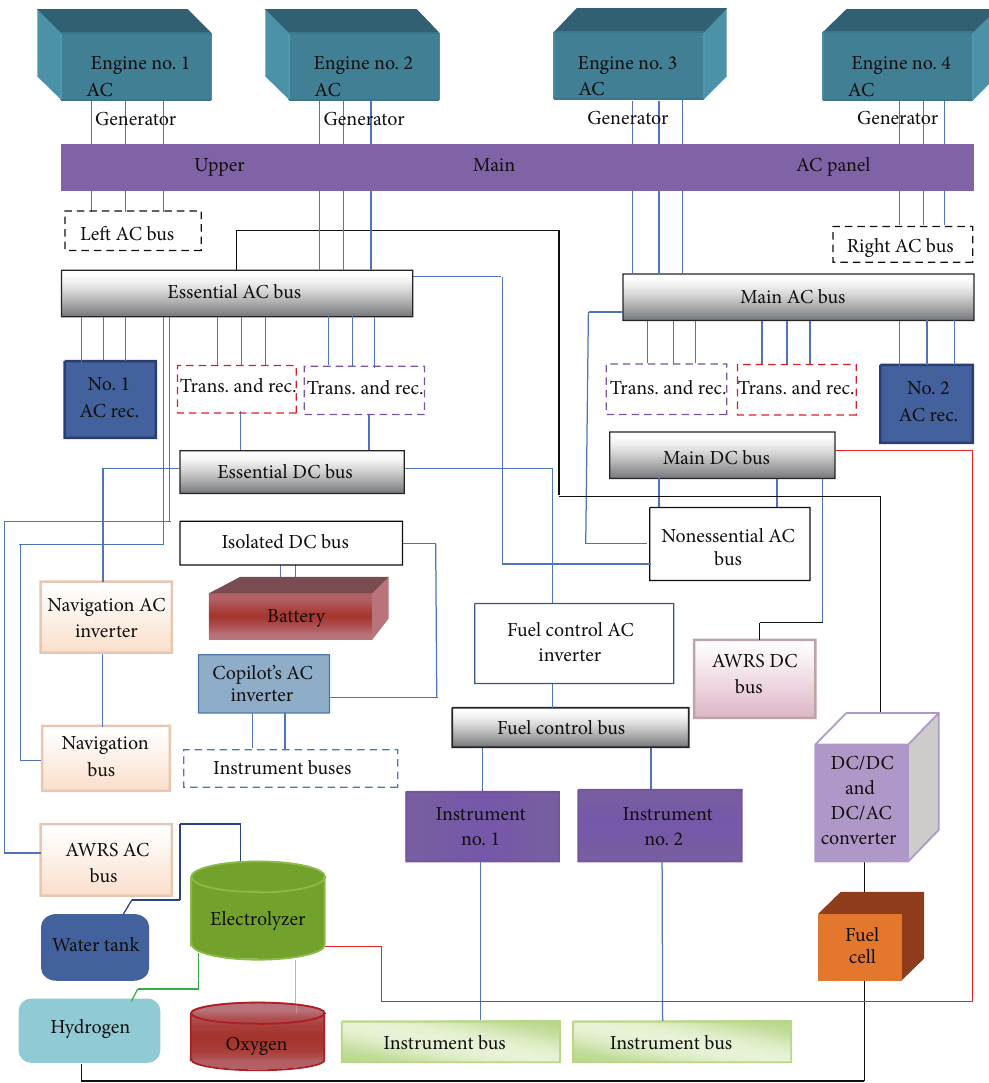
Figure 2: C-130 airplane electrical distribution system connected to